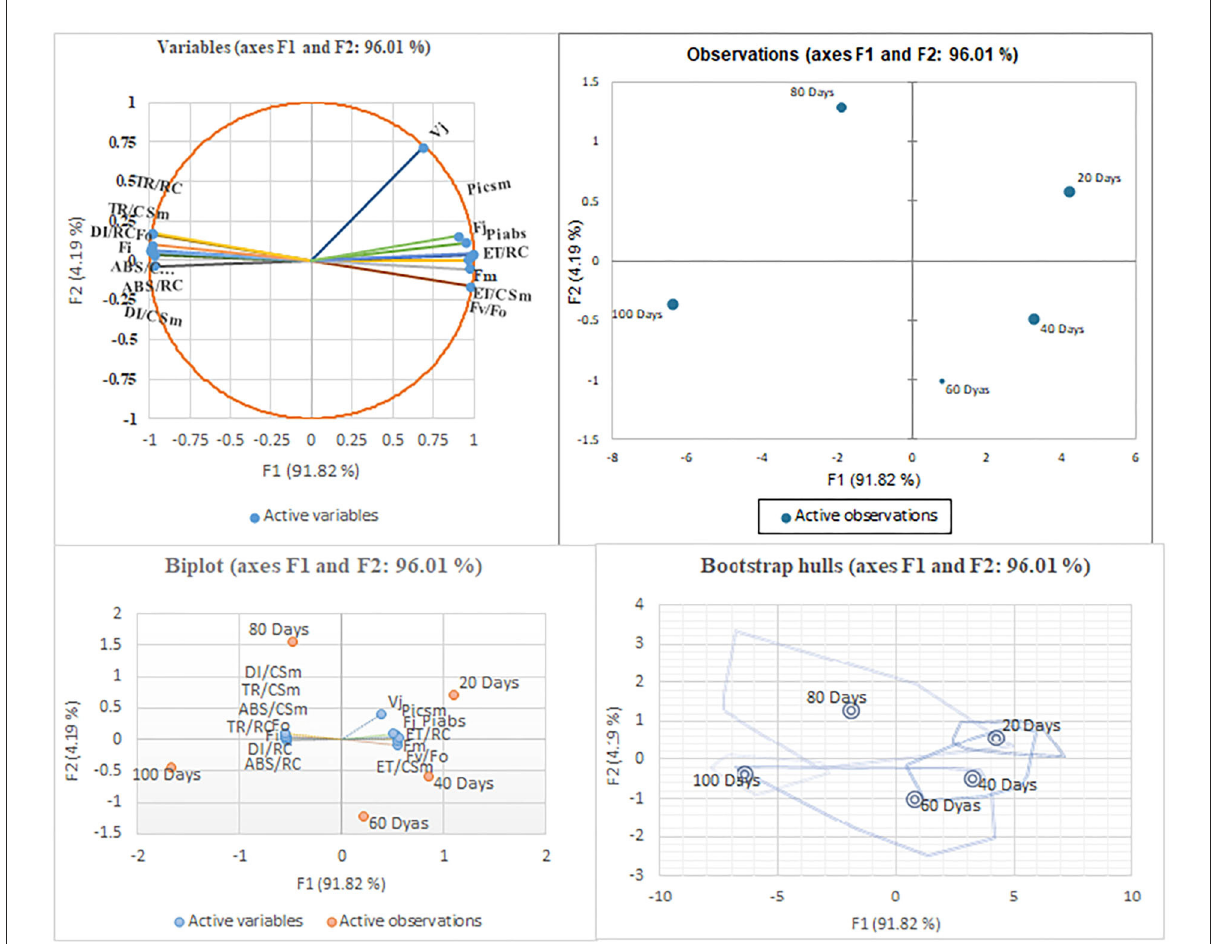
FIGURE12 The principal component analysis with different waterlogging treatment conditions. The PCA is based on the chlorophyll fluorescence data. Arrows represent the chlorophyll fluorescence parameter on the corresponding dimensions (PC 1 and PC2), where PC 2 expressed most of the variability in the data.